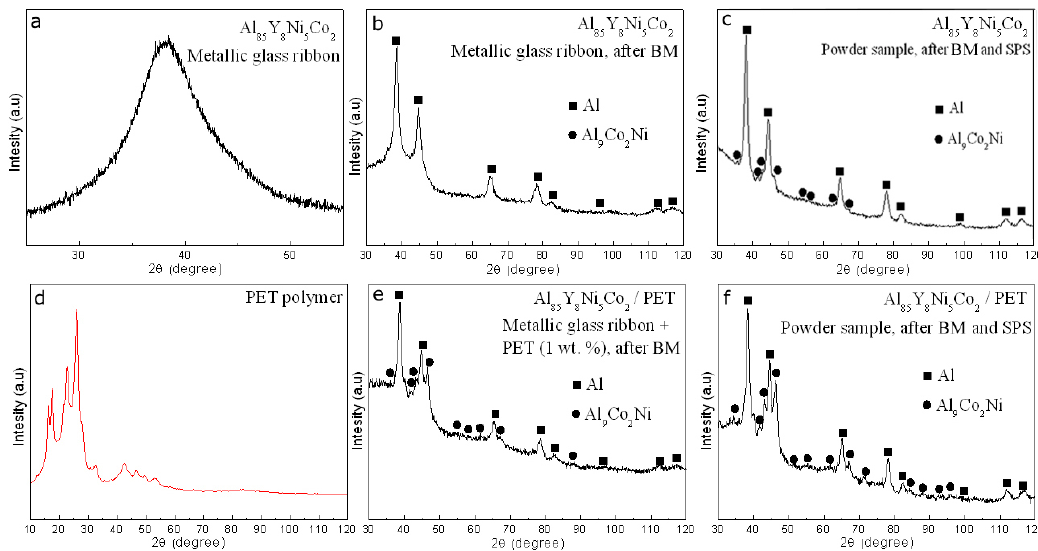
Figure 2. X-ray diffraction (XRD) pattern of the Al 85 Y 8 Ni 5 Co 2 ribbon ( a ), Al 85 Y 8 Ni 5 Co 2 ribbon, after ball milling (BM) ( b ), Al 85 Y 8 Ni 5 Co 2 bulk sample, after BM and spark plasma sintering (SPS) ( c ) and polyethylene terephthalate (PET) powder ( d ), composite Al 85 Y 8 Ni 5 Co 2 /PET powder, obtained BM ( e ), composite Al 85 Y 8 Ni 5 Co 2 /PET bulk sample, obtained by BM and SPS ( f ). Table 1. Phase composition of the obtained samples.